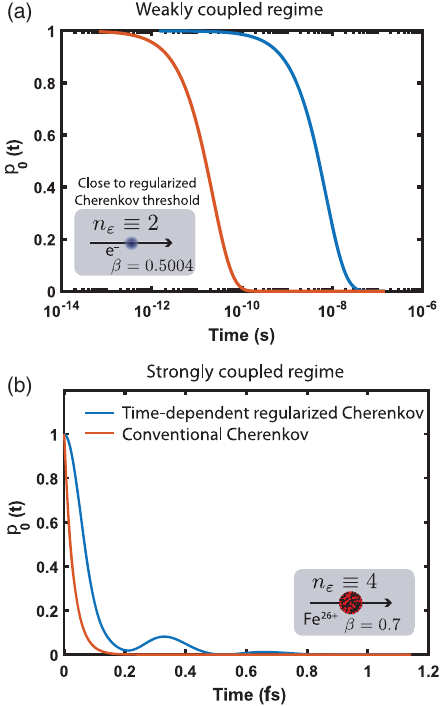
FIG. 3. The modified Cherenkov velocity threshold. (a) Regu- larized decay rate (blue curve) as a function of the distance to the FIG. 4. Modified time dynamics in weakly and strongly conventional Cherenkov threshold β coupled regimes. (a) Comparison of the regularized and conven- , above this threshold. th tional evolution of p 0 ð t Þ for an electron very close to the (b) Probability of no Cherenkov emission p 0 ðþ ∞ Þ as a function ¯ β ¯ β ≈ 3 × 10 − 5 . Here, an of the distance to the conventional Cherenkov threshold regularized Cherenkov threshold β − , th th below this threshold. The system considered for this example is a electron propagating at a speed of β ¼ 0 . 5004 emits a photon single electron traversing an index window defined by n ε ¼ (e.g., its zero-photon state probability decays) at a rate that is 2 2 (cid:4) 1 ð ε ∈ ½ 0 ; 5 eV (cid:2)Þ [where 1 ð ε ∈ A Þ is the indicator function of orders of magnitude less than the conventional prediction. (b) In strongly coupled regimes, the presence of several poles of the a subset of energies A ]; however, similar effects occur regardless function f ð z Þ can result in a pseudoperiodic decay of p 0 ð t Þ of the choice of particle or transparent index medium.